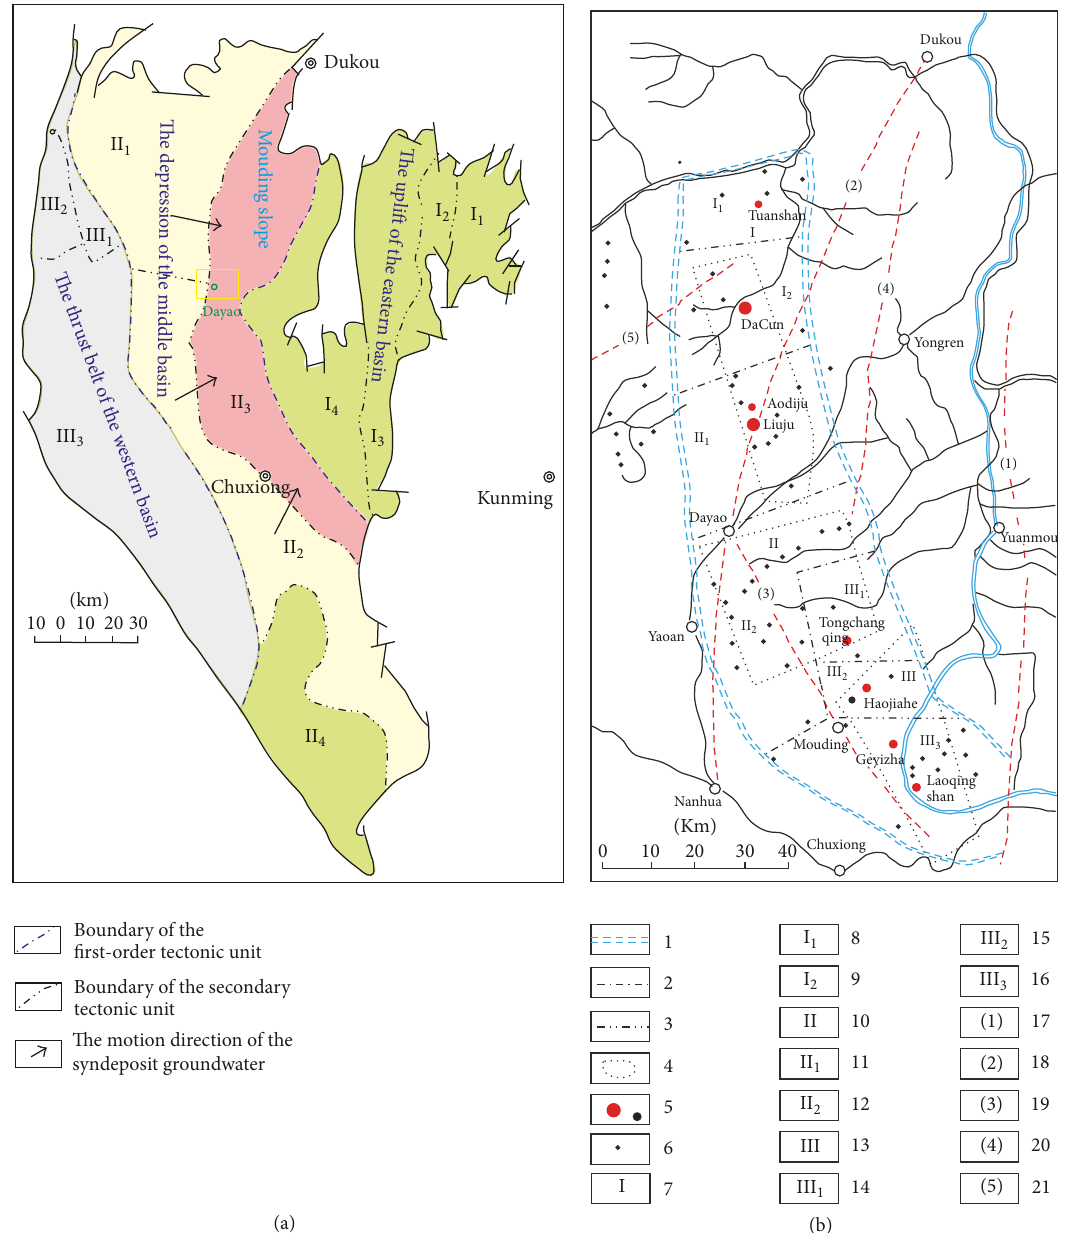
Figure 1: The tectonic unit (a) and arcuate red-bed copper belt (b) in Chuxiong basin (modified from [51]). (a) I: the uplift of the eastern basin; I1:Yunlongdepression;I 2 :Yinachangsalient;I 3 :Dongshandepression;I 4 :Yuanmousalient;II:thedepressionofthemiddlebasin;II 1 :Yanfeng depression; II 2 : Shuangbai depression; II 3 : mouding slope; II 4 : Dahongshan salient; III: the thrust belt of the western basin; III 1 : Pingchuan salient; III 2 : Pianjiao depression; III 3 : the thrust belt of the western basin. (b) 1: the red-bed copper belt; 2: mineralization concentration area; 3: mineralization area; 4: anomaly of Cu-Pb-Zn; 5: medium-small scale copper deposit; 6: copper spot; 7: Tuanshan-Dacun mineralization concentration area; 8: Tuanshan-Wulong area; 9: Dacun area; 10: Liuju-Longjie mineralization concentration area; 11: Liuju area; 12: Longjie area; 13: Sanmu-Tongchangqing-Shibanhe mineralization concentration area; 14: Sanmu-Tongchangqing area; 15: Haojiahe area; 16: Geyizha- Shibanhe area; 17: Lvzhijiang fault; 18: Dukou-Nanhua fault; 19: Qian Chang-Mouding fault; 20: Lixidong fault; and 21: Binchuan-Wulong